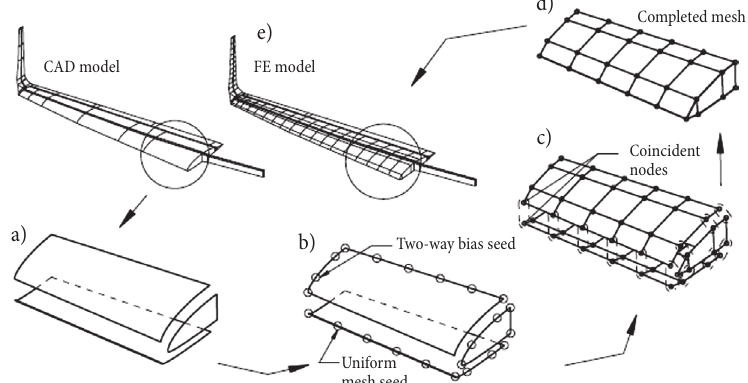
Fig. 1. The airframe modelling stages (shown on 15 m outer wing): a – surfaces generation; b – mesh seeding; c – meshing; d – equivalencing; e – finished mesh